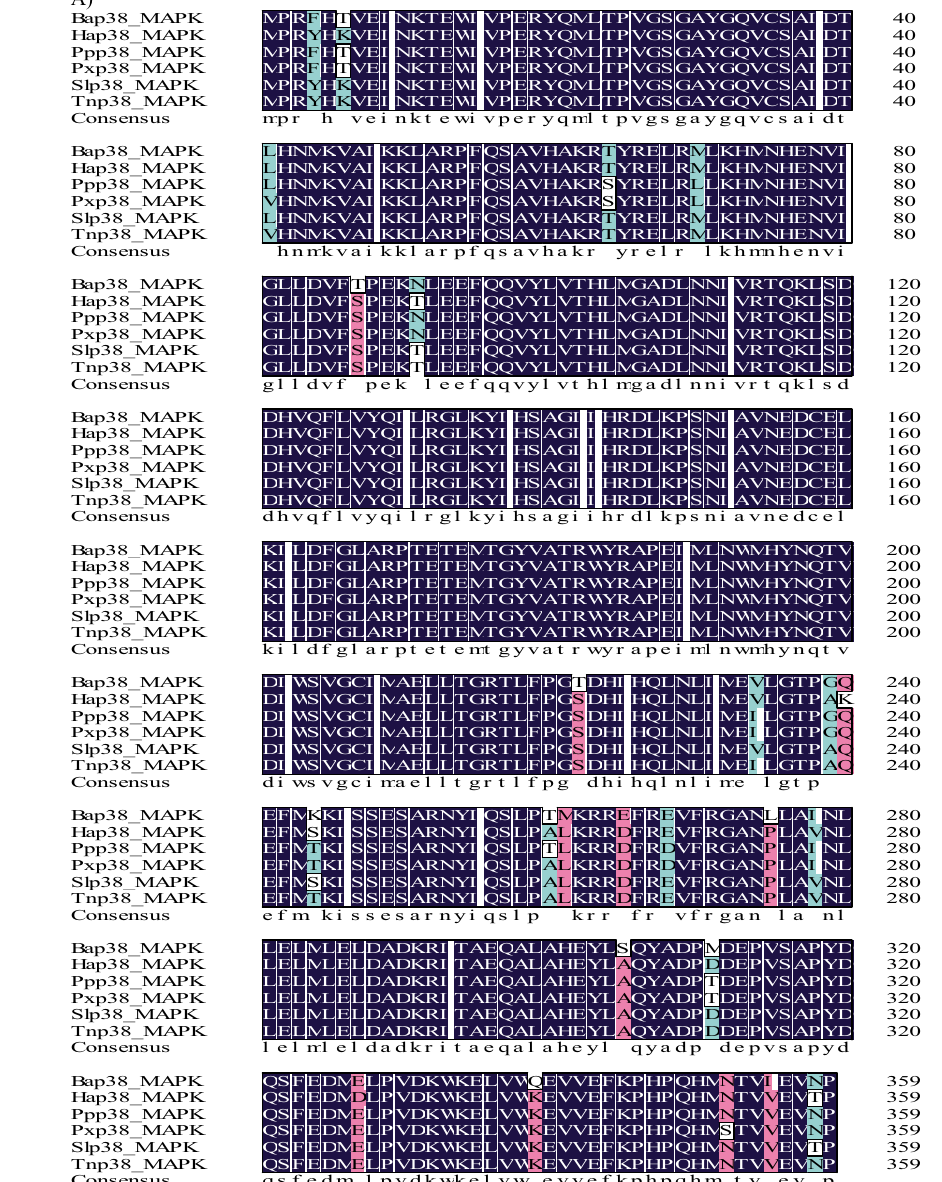
Figure 1. Sequence characterization of p38 MAPK from various species. ( A ) Multiple alignments of the amino acid sequences of Hap38 MAPK with homologs from other insect species. Black represents 100% identity, red represents ≥ 75% identity, green represents ≥ 50% identity, and white represents < 50% identity. Hap38 MAPK ( Helicoverpa armigera , MK185422), Slp38 MAPK (Spodoptera litura , XP_022822243.1), Tnp38 MAPK ( Trichoplusia ni , XP_026739071.1), Ppp38 MAPK ( Papilio polytes , XP_013133297.1), Pxp38 MAPK ( Papilio xuthus , XP_013177389.1), and Bap38 MAPK ( Bicyclus anynana , XP_023935784.1). ( B ) Phylogenetic tree of p38 MAPKs from H. armigera (Ha) and other species. The tree was constructed from a multiple alignment using the MEGA6.0 software, and generated with 1000 bootstrap trials using the neighbor-joining method. The numbers show the bootstrap confidence values obtained for each node after 1000